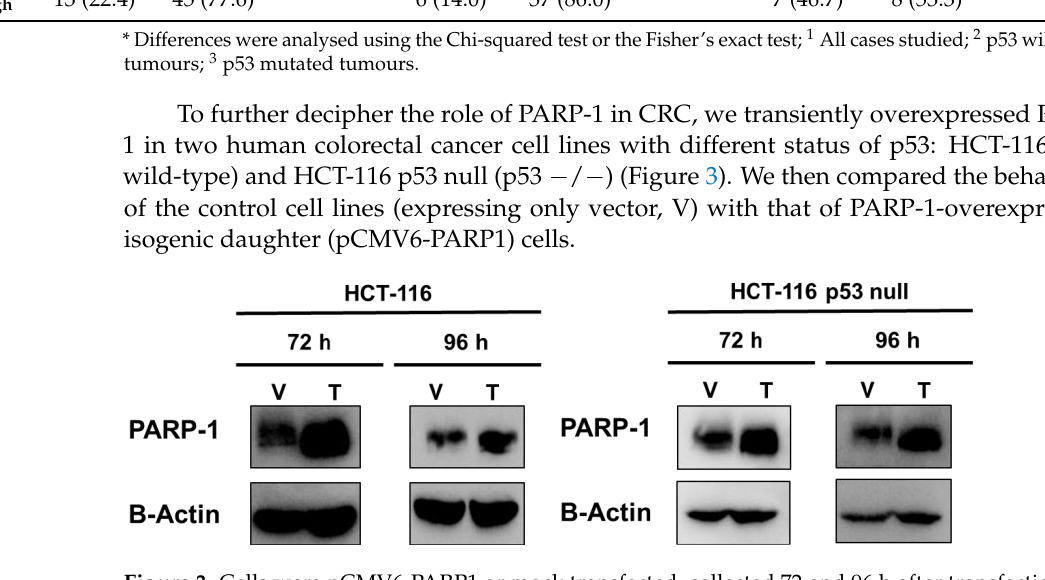
Figure 3. Cells were pCMV6-PARP1 or mock transfected, collected 72 and 96 h after transfection and analysed by Western blotting to ensure overexpression of PARP-1.